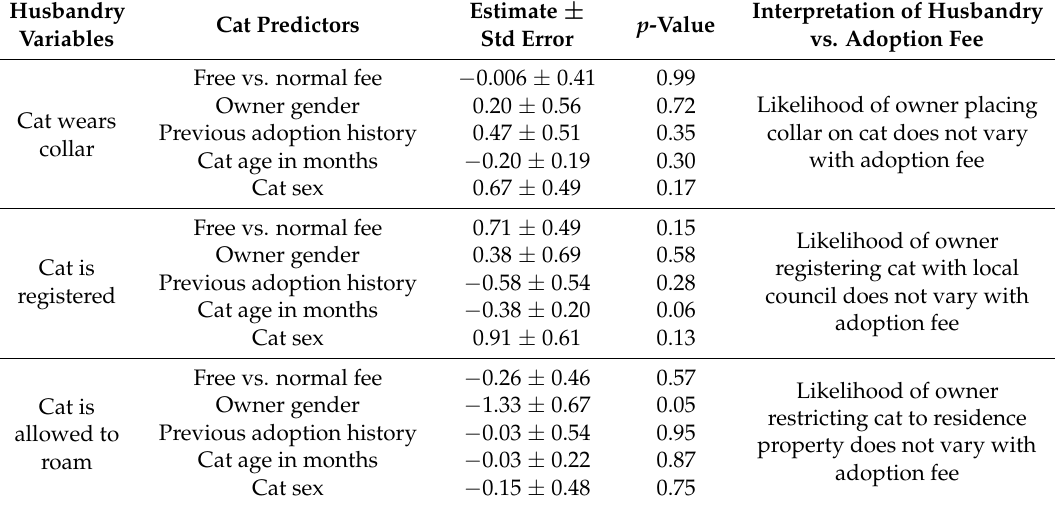
Table 6. Mixed-effect hierarchal modelling used to assess relationship between free and normal-fee adopter husbandry response variables and adopted cat predictors. Effects with p -values between 0.01 and 0.05 were considered as offering modest significance and effects with p < 0.01 as offering stronger evidence of a